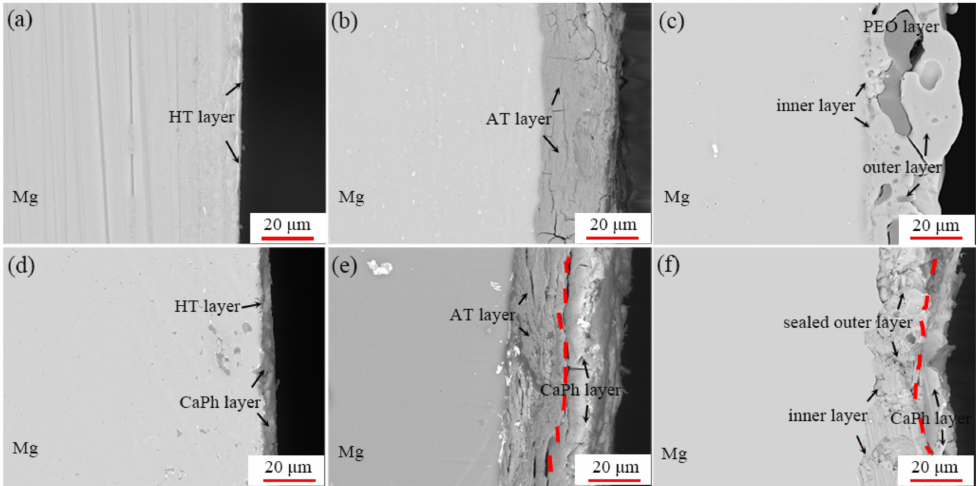
Figure 3. Cross-sections of the pre-treated substrates and CaPh-coated samples: ( a ) HT sample; ( b ) AT sample; ( c ) PEO sample; ( d ) HT-C sample; ( e ) AT-C sample; ( f ) PEO-C sample.